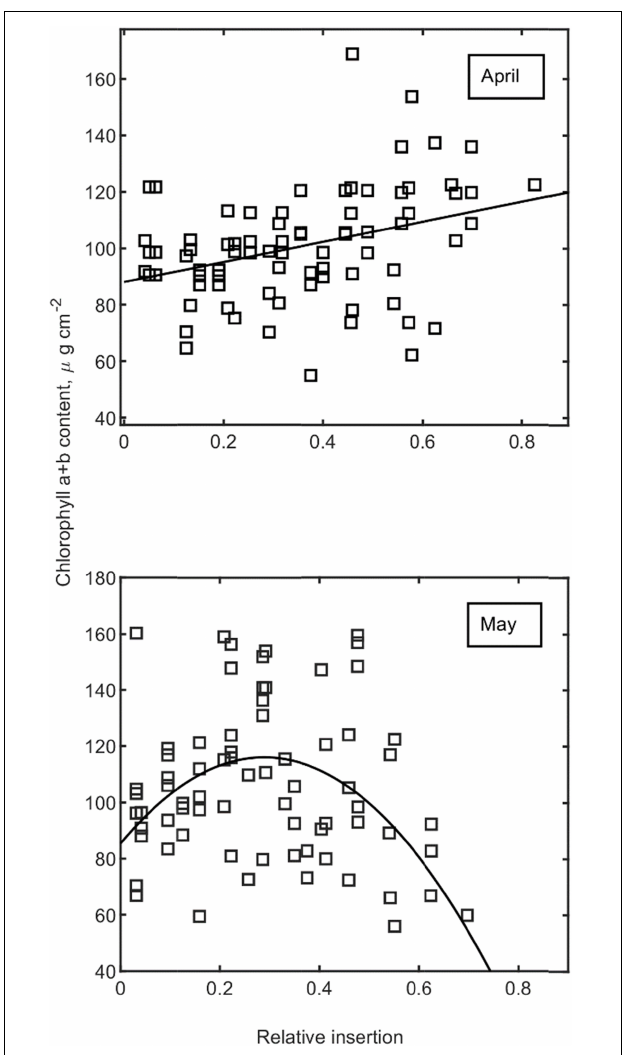
FIGURE 1 | Estimated vertical profiles of chlorophyll content as a function of relative insertion (top leaves = 1, bottom leaves = 0) for the months of April and May. Single estimates (symbols) with linear and quadratic regression functions for April and May, respectively.